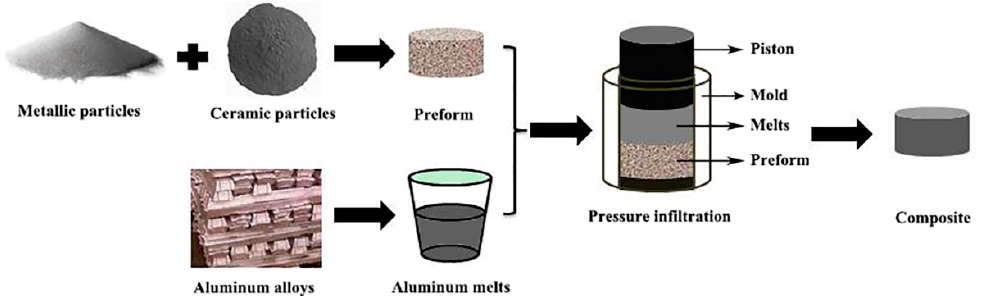
Figure 2. Fabricating processes of composites.